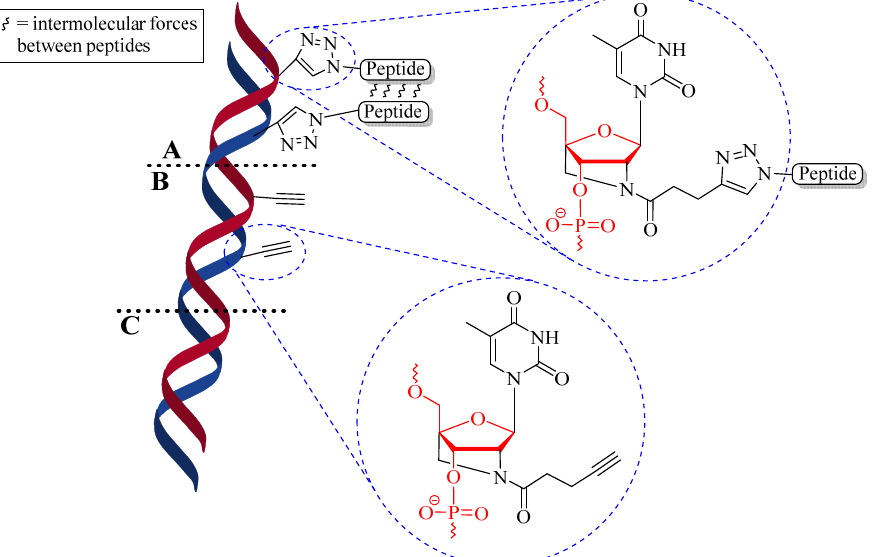
Figure 5. Structural comparison between; ( A ) CuAAC locked-DNA; ( B ) locked-DNA; and ( C ) unmodified DNA. Red structures highlight the DNA